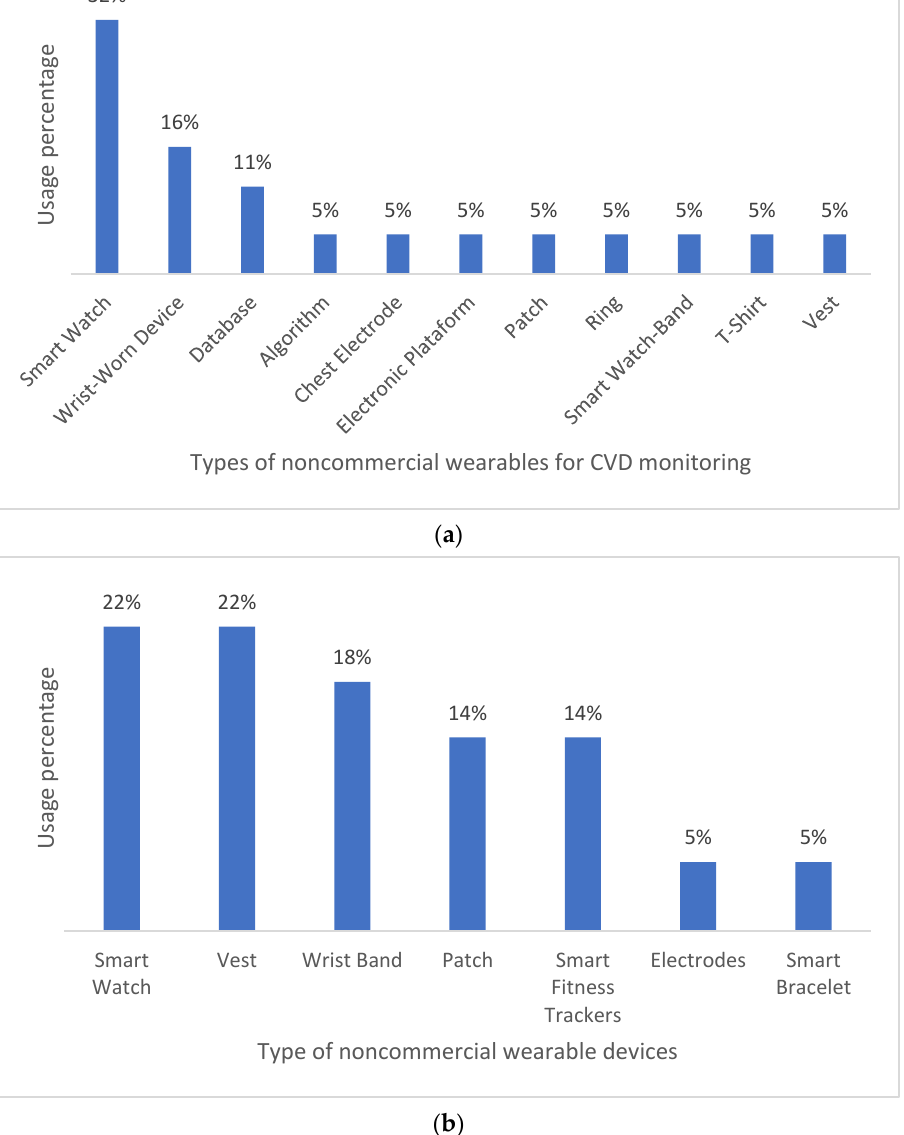
Table 4. Noncommercial wearables with real-time monitoring capabilities. CVD Type